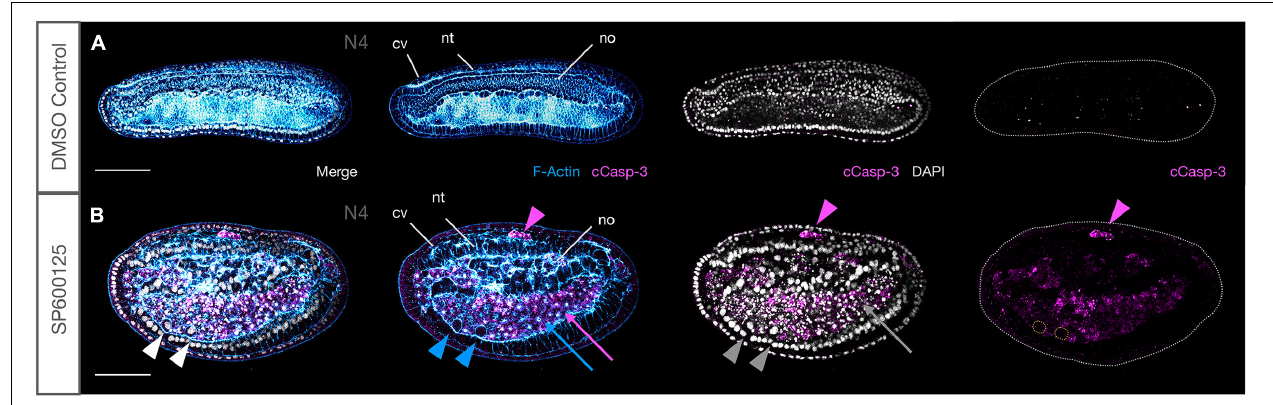
FIGURE 8 | JNK inhibition induces Caspase-3-mediated apoptosis. (A) Under ordinary control conditions, there is no Caspase-3-mediated apoptosis in N4 embryos. (B) JNK inhibition with SP600125 causes dramatic accumulation of cleaved Caspase-3 in cells that have been extruded between the neural tube and epidermis (magenta arrowhead), around the notochord and within the accumulated cells of the archenteron where pycnotic nuclei (grey arrow) and F-Actin aggregates (blue arrow) are observed. Rounded cells that have delaminated with strong membrane staining and no F-Actin aggregates have intact nuclei and are cCasp-3 − . Note how ventral cells highlighted by white, blue, and grey arrowheads lack cCasp-3 staining in single magenta channel (cells outlined with yellow dotted lines). Representative embryos are shown. Phalloidin staining of F-Actin is in blue and cleaved Caspase-3 (cCasp-3) immunoreactivity is in magenta, while DAPI stained nuclei are in grey. Embryos are orientated with anterior to the left and dorsal up. cv, cerebral vesicle; nt, neural tube; no, notochord. Scale bars = 50 µ M.